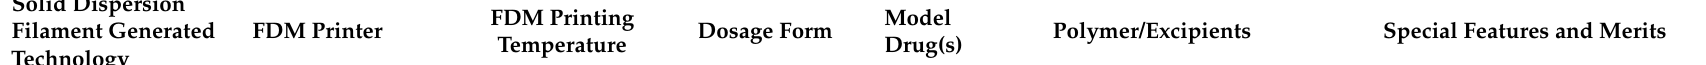
Table 1. Some examples of solid dispersion technologies coupled FDM additive manufacturing and their various applications in personalized